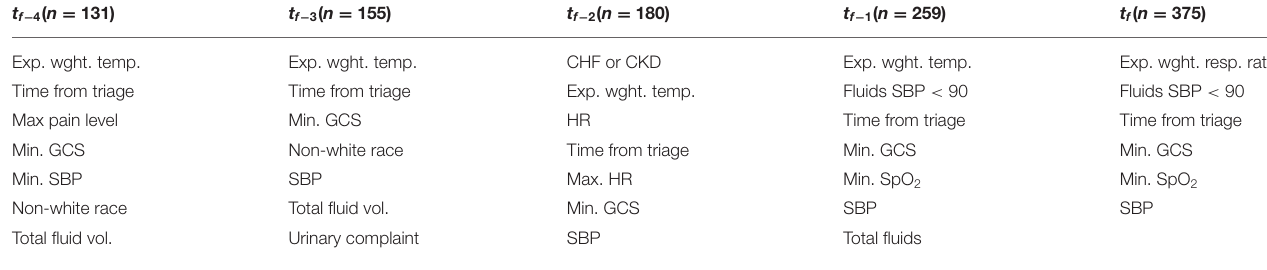
TABLE 3 | Final compositions of models trained at earlier observation times, with number of available encounters noted. t f − 4 ( n = 131)